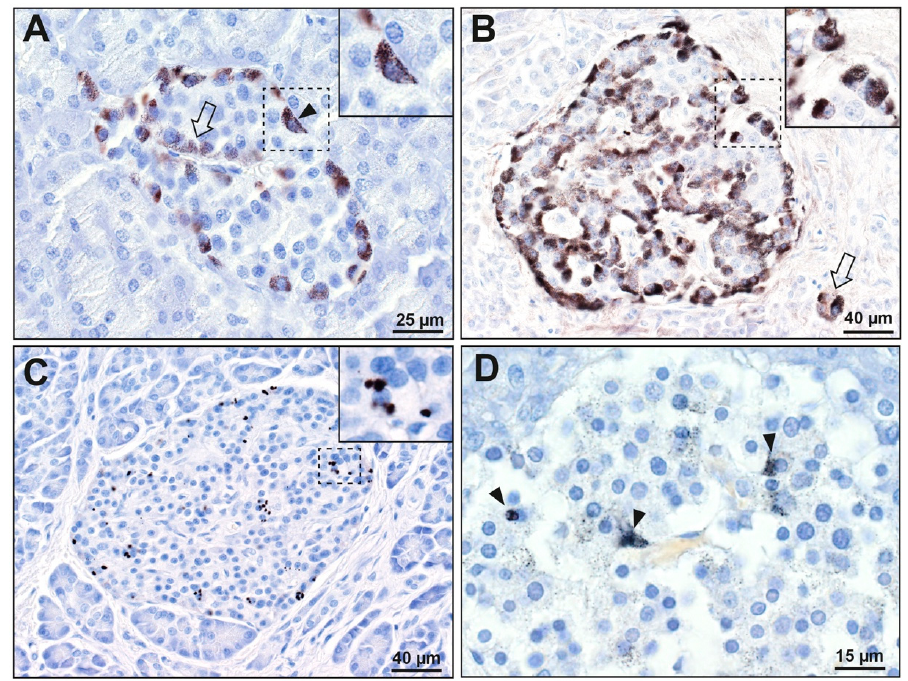
Figure 2. Mercury in pancreatic islet cells. ( A – C ): pancreatectomy samples. ( D ): autopsy sample. The areas in the dashed rectangles are shown at higher magnifications in the insets. ( A ) Black mercury grains are present in most peripheral cells (e.g., arrowhead) of this islet, as well as in a few internal cells adjacent to microvessels (e.g., arrow). ( B ) Black mercury grains in this islet are present in the cytoplasm of all peripheral cells, as well as in most internal cells adjacent to microvessels. Two cells outside the islet (arrow, probably ectopic islet cells) contain mercury. ( C ) Numerous dense black mercury granules are visible within peripheral and internal cells of this islet, usually adjacent to cell nuclei. ( D ) Fine black mercury grains are present in many scattered cells of this islet, with denser staining in three cells (arrowheads). Autometallography/hematoxylin.